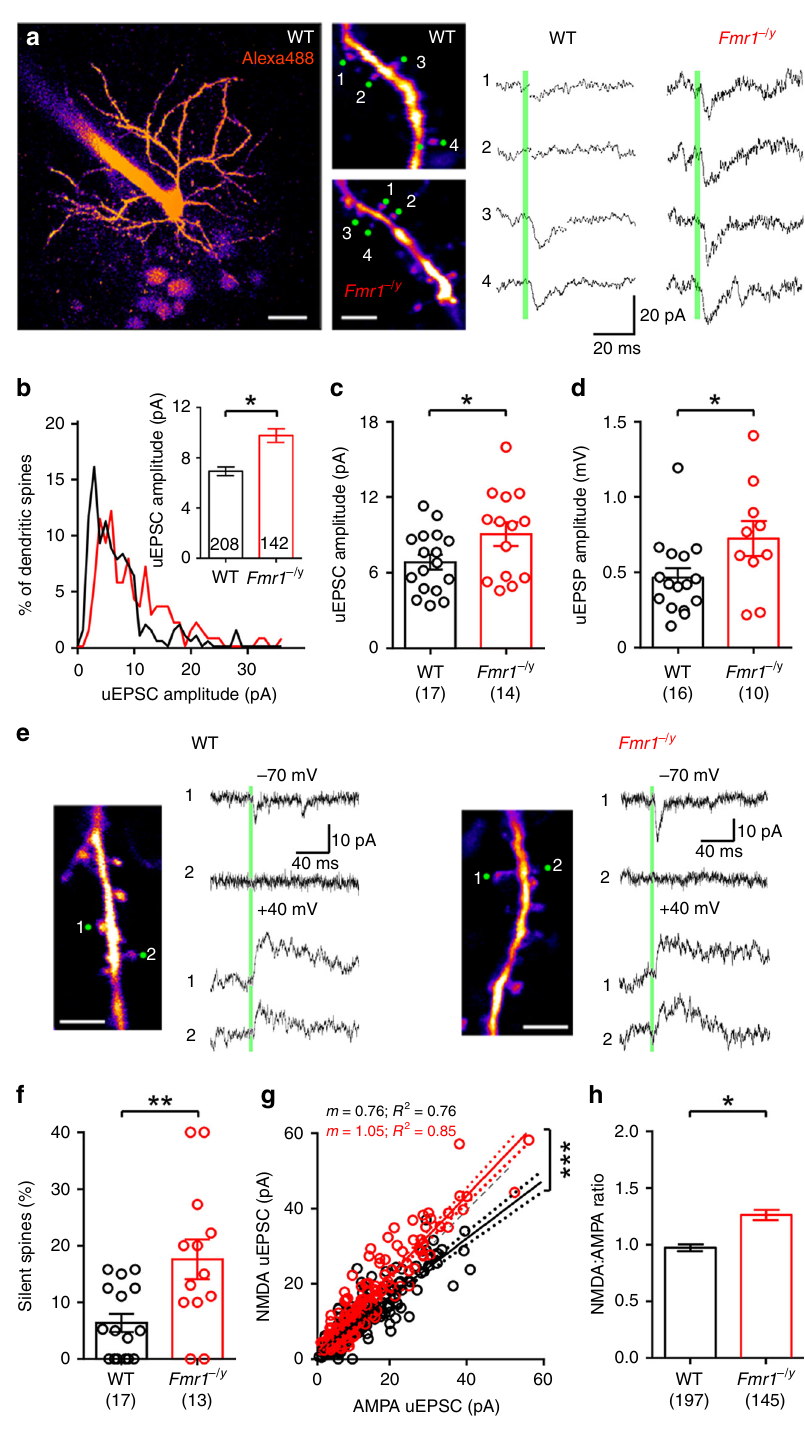
Fig. 1 L4 SC dendritic spines have larger uEPSCs with more silent synapses in Fmr1 − /y mice. a 2-photon image of a L4 SC (left) with selected spines and AMPAR uEPSCs from WT and Fmr1 − /y mice. Scale bars: 20 µ m (left), 5 µ m (right). b Single-spine uEPSCs from WT (black) and Fmr1 − /y (red) mice shown as a histogram, with spine average shown (inset). Note that spines with no AMPA response, silent spines have not been included. c Animal average uEPSC amplitudes, excluding silent spines. Number of animals tested shown in parenthesis. d Animal average of uEPSP amplitudes. e AMPAR (upper) and NMDAR (lower) uEPSCs, illustrating silent spines. Scale: 5 µ m. f Incidence of silent spines in WT and Fmr1 − /y mice. g AMPAR and NMDAR uEPSCs for all spines, with NMDA/AMPA ratio (WT: 0.76 ± 0.03; Fmr1 − /y ; 1.05 ± 0.04; d.f.: 1, 331; F = 37.4; p < 0.0001; F-test). h Average NMDA/AMPA ratio plotted for all spines. Statistics shown: * p < 0.05, ** p < 0.01, from LMM ( b , d , h ), unpaired t -test ( c , f ) and sum-of-least-squares F-test ( g ). Plots of individual spine data for panels c (inset) and h can be found in Supplementary Fig. 4. All data are shown as mean ± SEM and source data for all plots are provided as